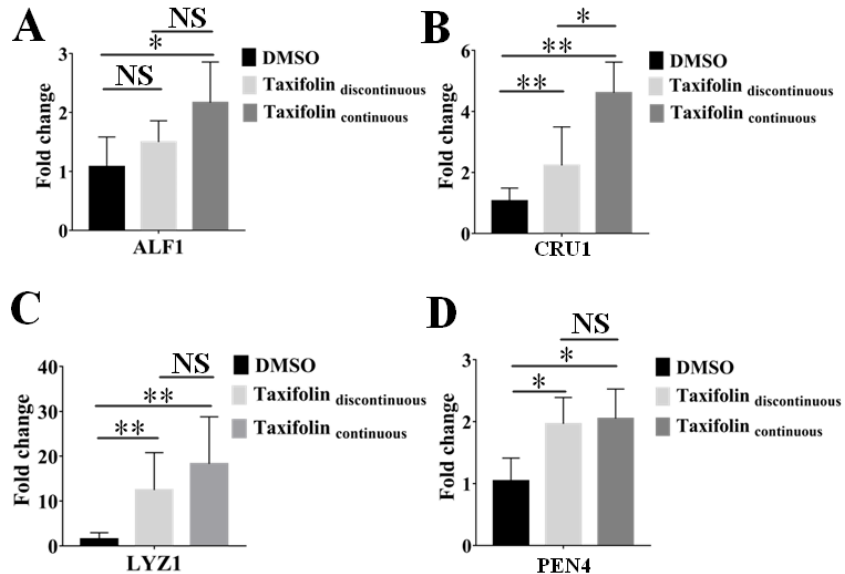
Figure 7. The expression level of immune-related genes in shrimp was increased by taxifolin. The innate immune response of shrimp larvae was analyzed after exchanged or non-exchanged new taxifolin for five days. The relative RNA levels of ALF1 ( A ), CRU1 ( B ), LYZ1 ( C ), and PEN4 ( D ) were determined by qPCR at 120 h. Each sample was run in triplicate normalized to shrimp EF1 α . Each value was represented as the mean ± SD normalized to values for no treatment. The p value for each study was determined by Student’s t -tests. ** p < 0.01; * p < 0.05; NS p > 0.05.